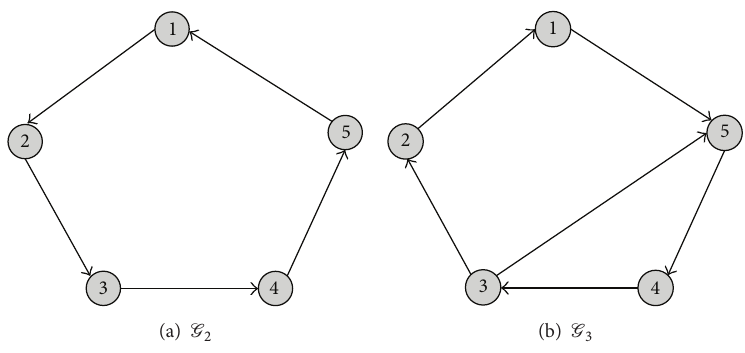
Figure 4: Interaction topologies G 2 and G 3